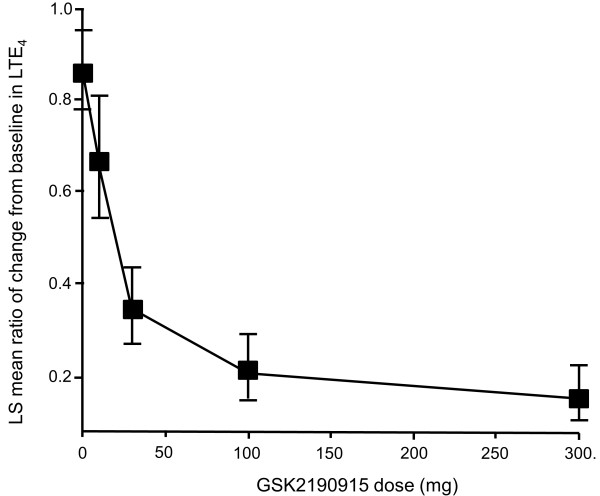
Dose–response plot of urinary LTE4. Ratio of mean change from baseline in urinary LTE4. Error bars represent 95% confidence interval. LS = least squares.